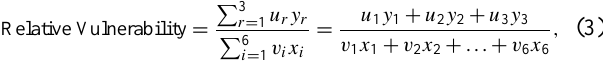
Fig. 7. The flood affected area (a) , human casualties (b) , and economic loss (c) regional Fig.7.The flood affected area(left),suffered population(middle) and economic loss(right) regional variation Fig.7.The flood affected area(left),suffered population(middle) and economic loss(right) regional variation Fig.7.The flood affected area(left),suffered population(middle) and economic loss(right) regional variation